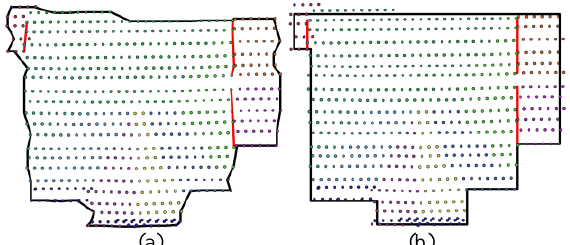
Figure 2. Detected building boundary (outer line segments) and step edges (inner line segments): (a) building boundary and step edges and (b) orientation